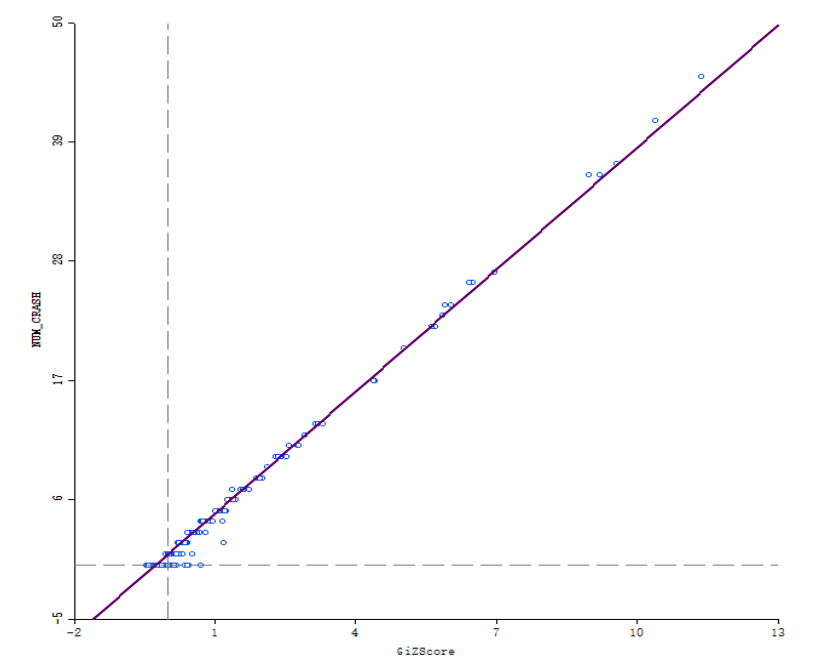
Figure 10. L inear regression between the number of crashes and the Gi * ZScore. Figure 10. Linear regression between the number of crashes and the Gi*ZScore. Appl. Sci. 2020 , 10 , x FOR PEER REVIEW